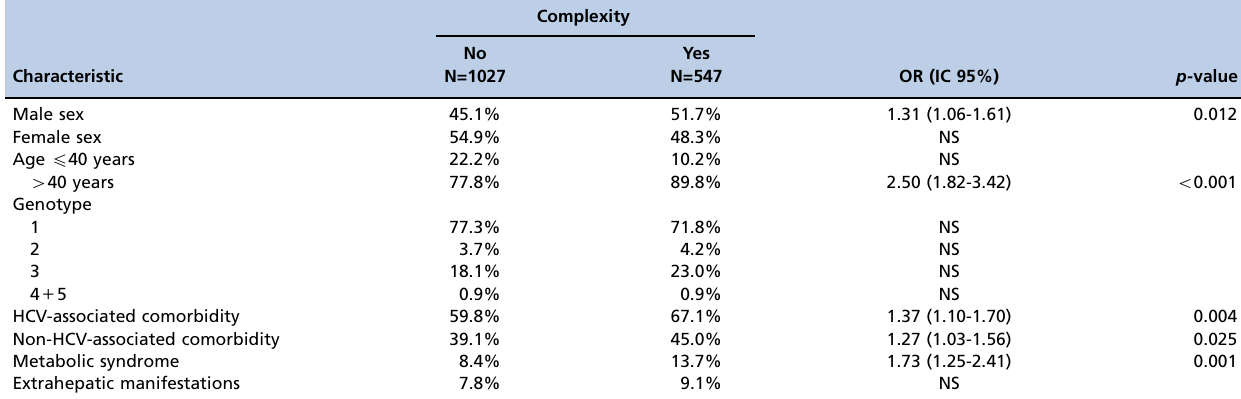
Table 3 - Demographic and clinical characteristics of patients according to the presence or absence of advanced liver disease* according to univariate analysis.